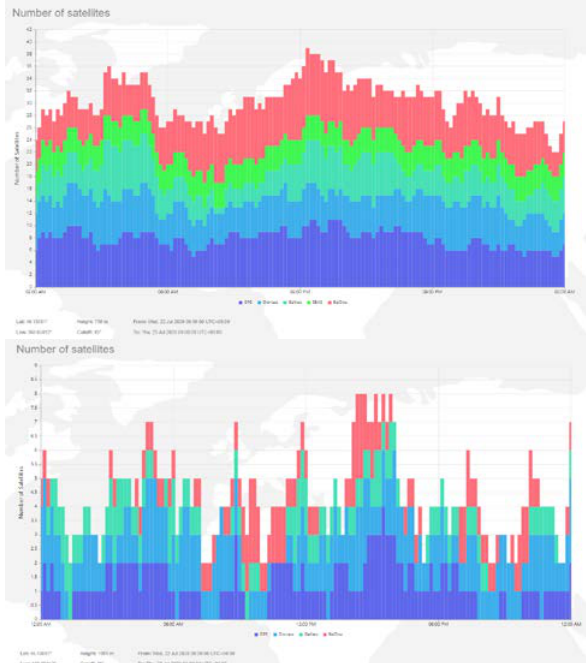
Figure 6. Analysis of the number of visible satellites from the rover station in the upper position on the landslide body, as obtained from Navmatix (2020). A time span of 24 hours was considered. In the results shown in the upper subfigure, no obstacles are considered; in the ones reported in the lower part, some simplified blocks were included to simulate the effect of terrain